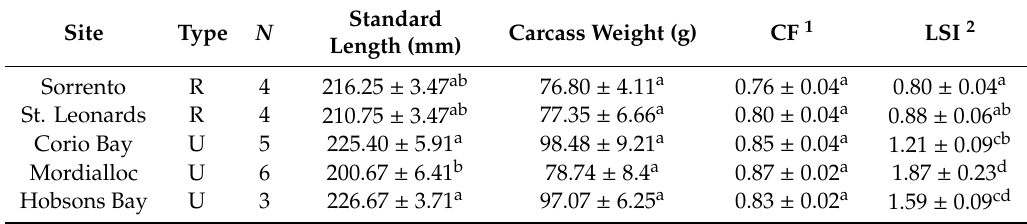
Table 2. Mean ( +/ − SEM) morphometric parameters in female sand flathead ( Platycephalus bassensis ) sampled at di ff erent sites within Port Phillip Bay. R = rural site; U = urban